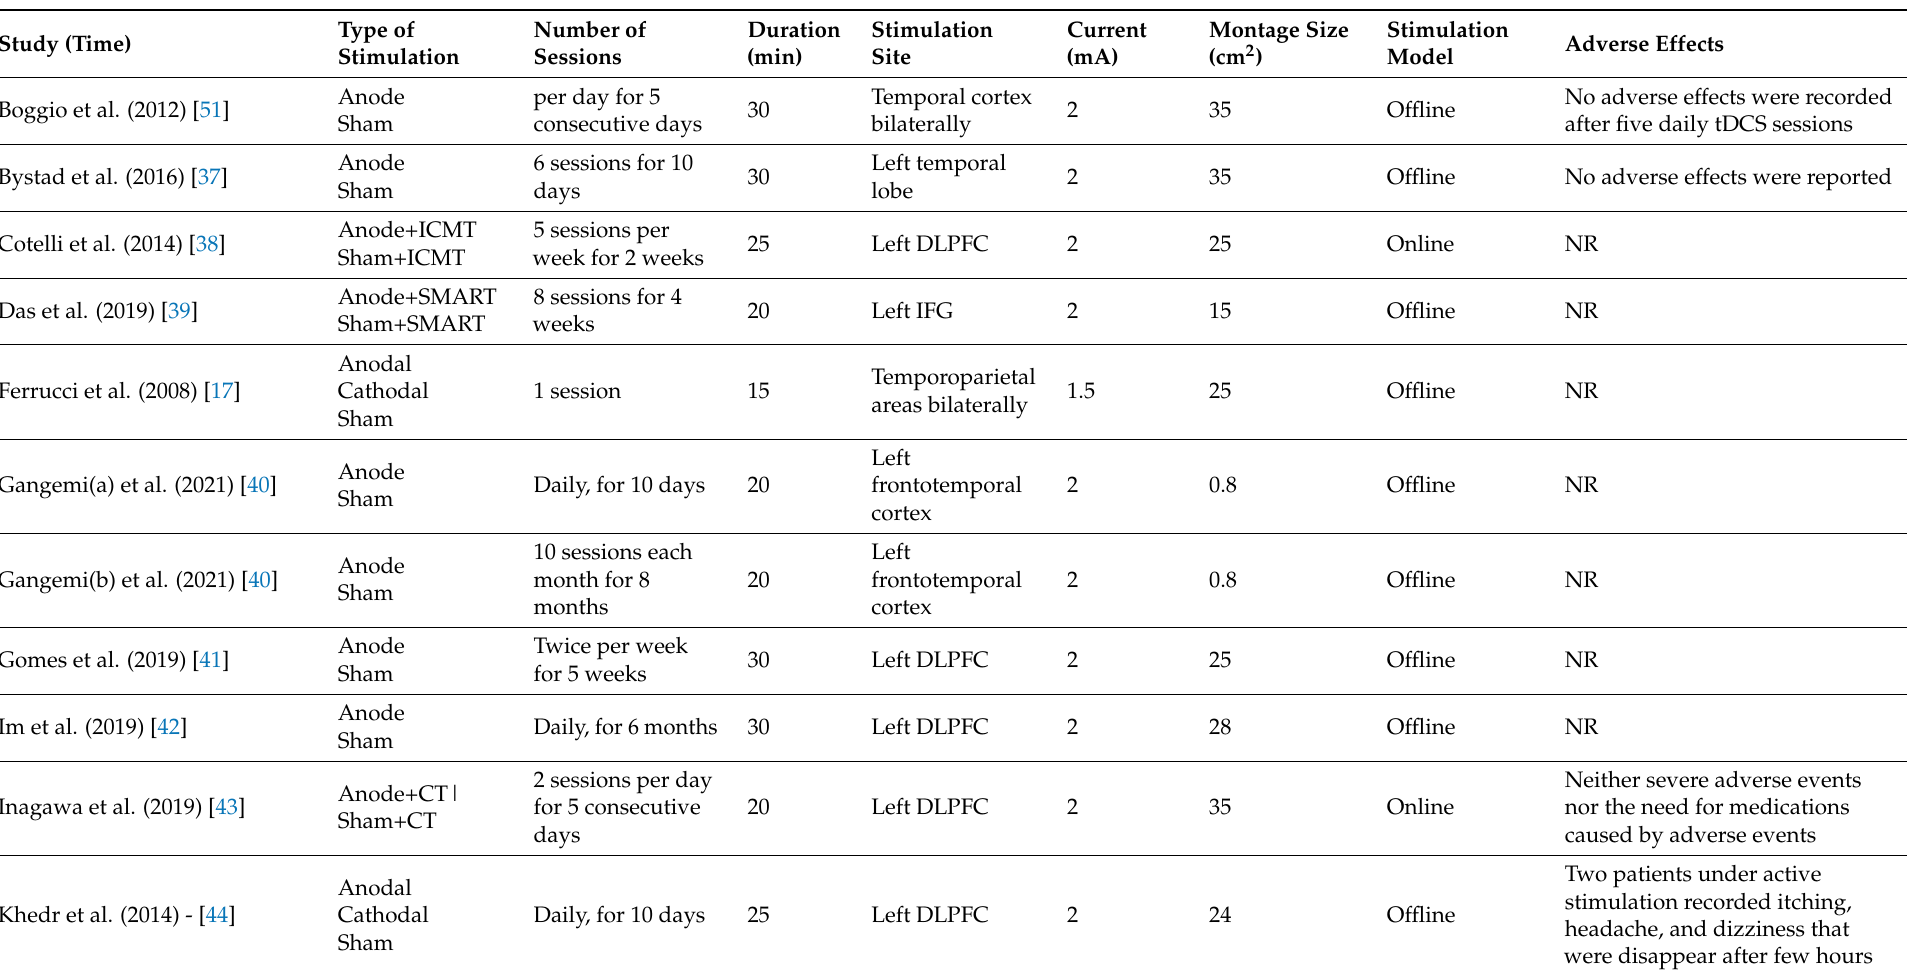
Table 2. The characteristics of tDCS